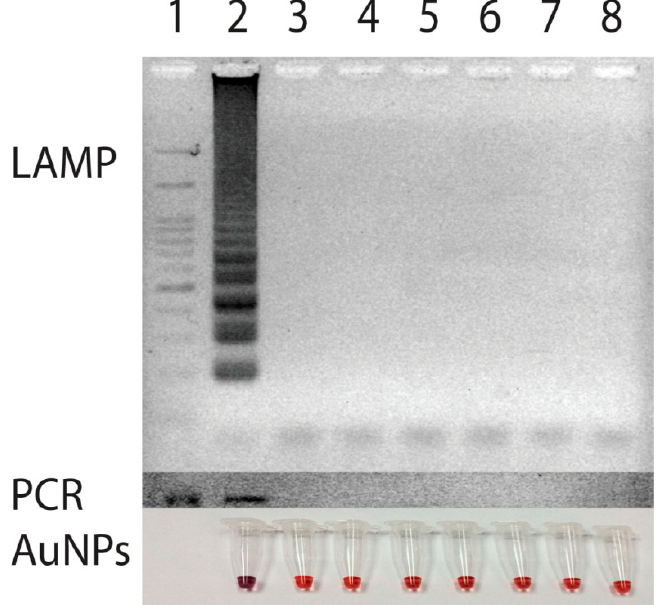
Figure 4. Specificities of LAMP amplification compared with that of PCR and gold nanoparticles detection, Lane 1, 100 bp marker. Amplification and detection were also carried out using DNA from Lane 2, Ehrlichia canis , Lane 3–7, negative control, Ehrlichia chaffeensis , Anaplasmapha gocytophila , Babesia canis , Hepatozoon canis , and Escherichia coli , respectively, Lane 8, non-template control. The amplification and detection of target gene could be obtained only from the template of E. canis